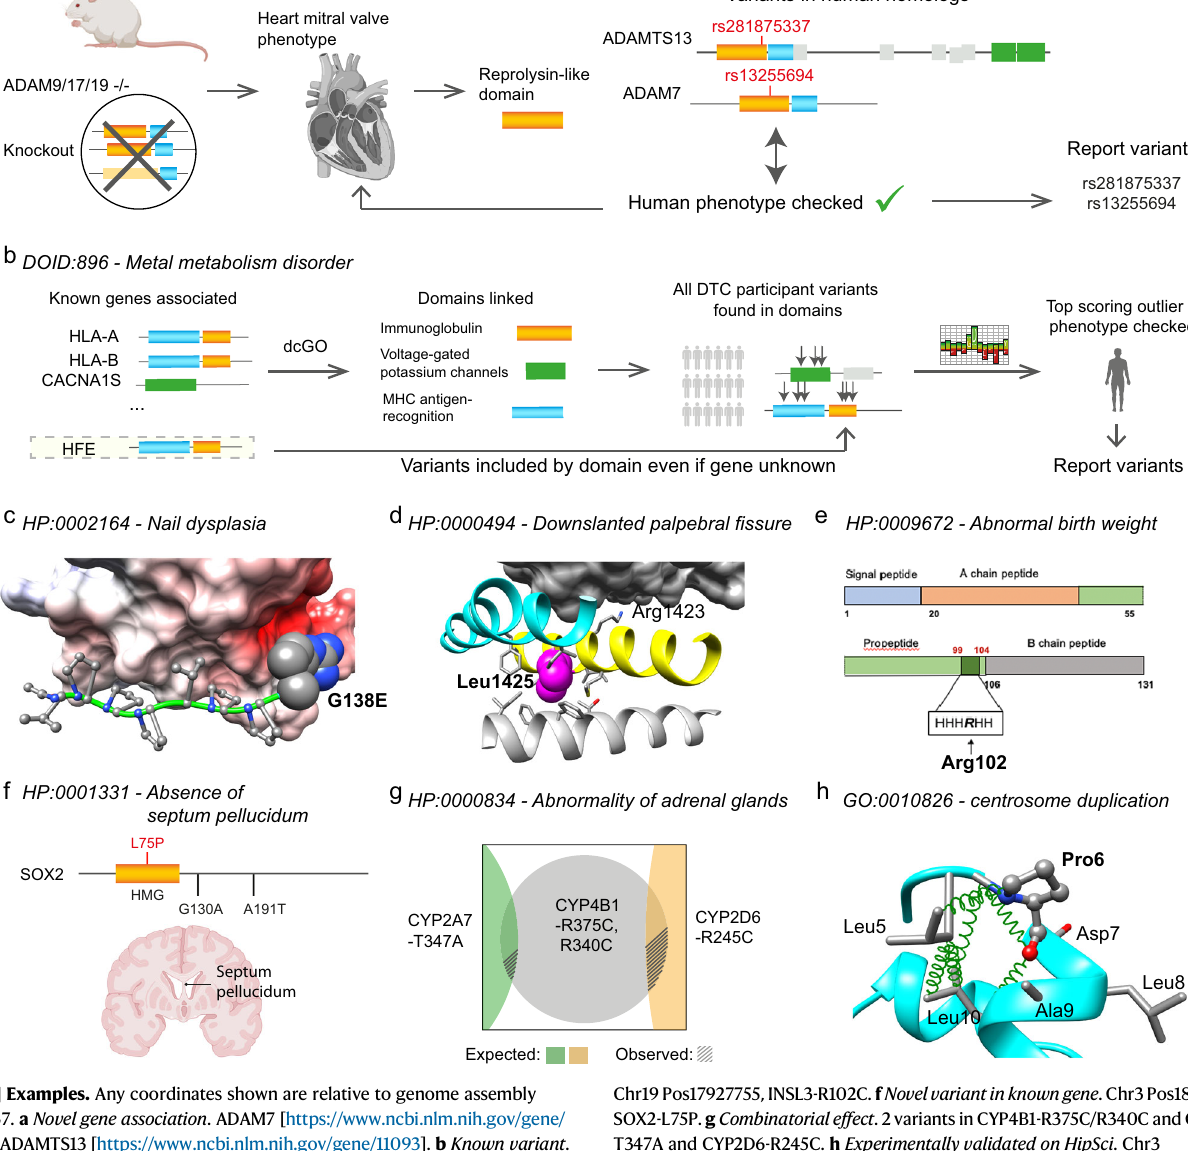
Fig. 6 | Examples. Any coordinates shown are relative to genome assembly GRCh37. a Novel gene association . ADAM7 [https://www.ncbi.nlm.nih.gov/gene/ 8756], ADAMTS13 [https://www.ncbi.nlm.nih.gov/gene/11093]. b Known variant . Chr6Pos26093141,HFE-C282Y. c Novelvariantinrelatedgene .Chr12Pos52913668, KRT5-G138E. d Single variant . Chr17 Pos29586054, NF1-L1425R. e Single variant .